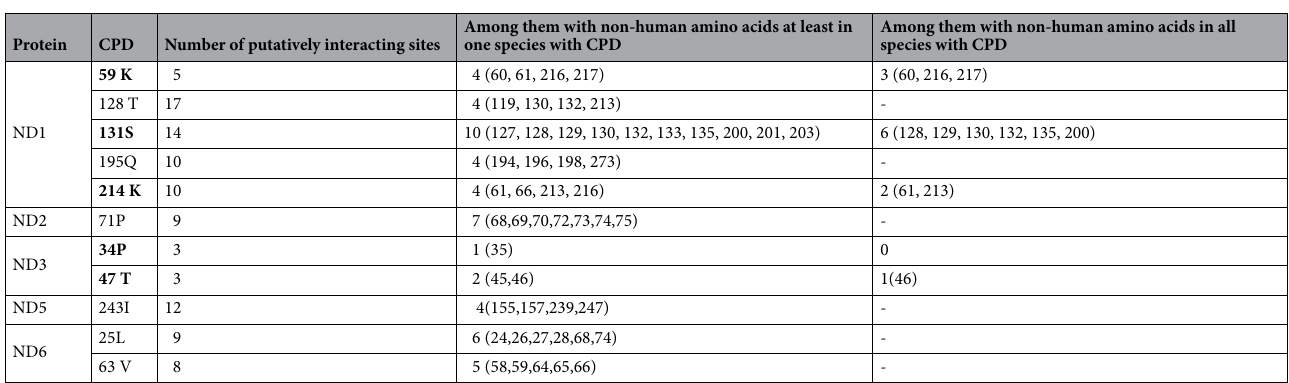
Table 2. Putative permissive substitutions in spatially close sites of the same protein. In the last two columns, there are number of positions, and positions are listed in brackets. Variants that are considered in detail below are shown in bold.